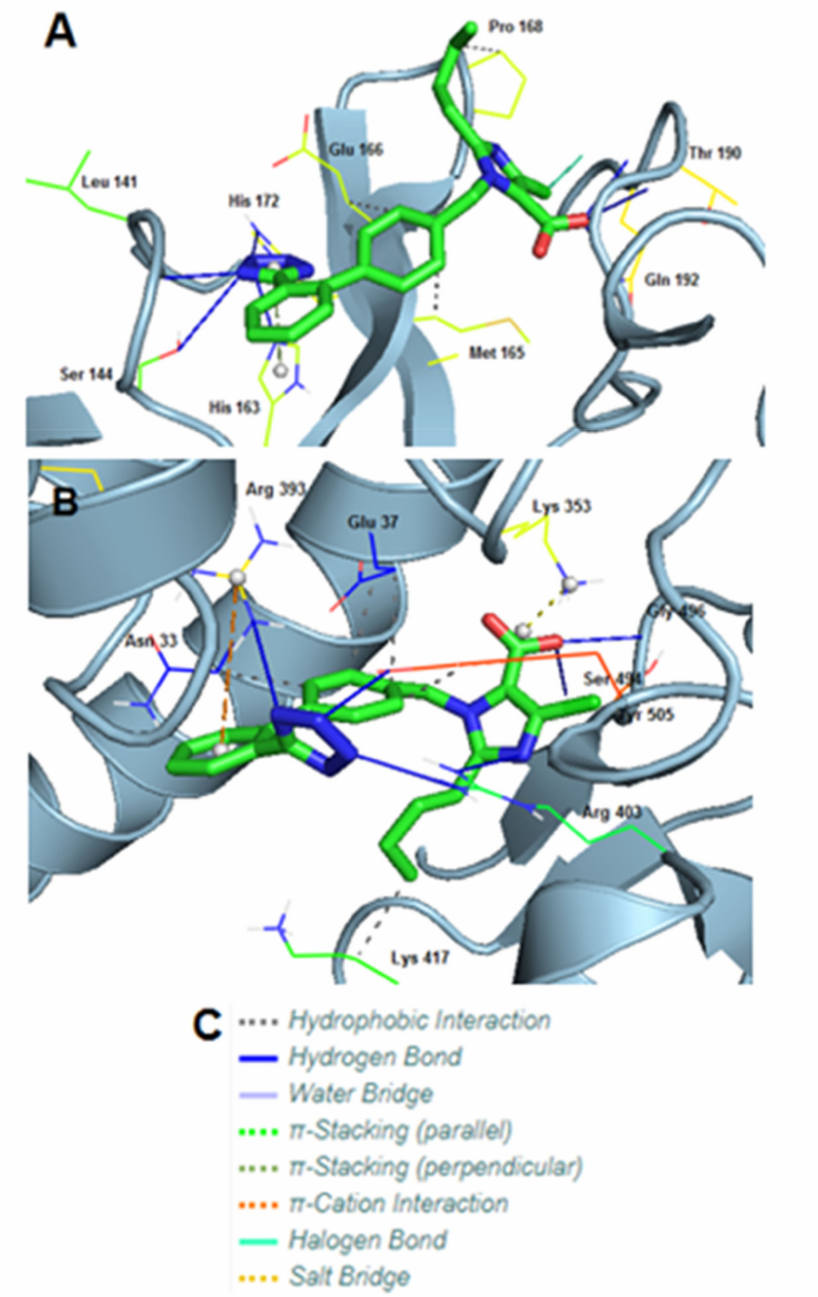
Figure 12. ( A ) EXP3174 incorporated in a cavity of Mpro of SARS-CoV-2 (PDB entry code: 6LU7), using crystallographic grid. ( B ) EXP3174 incorporated in a cavity of S-protein RBD (PDB entry code: 6LZG), of SARS-CoV-2 using crystallographic grid. ( C ) Depiction of the various protein-ligand interactions, according to